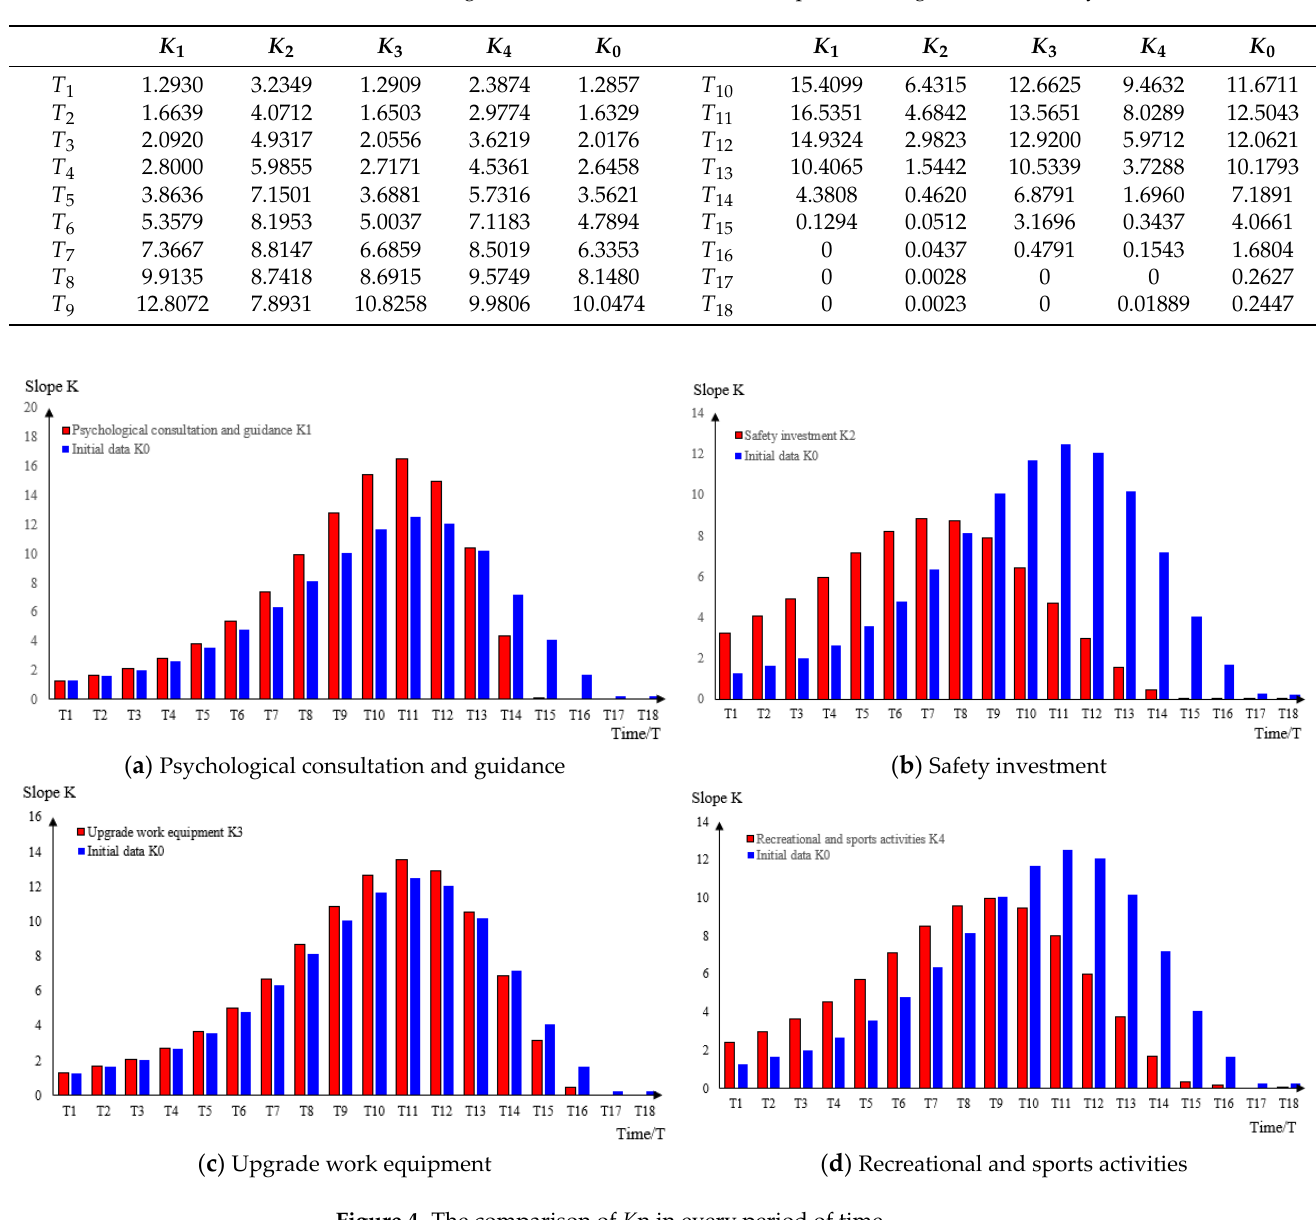
Table 2. The growth rate K with each decision power strengthened of EAP system.